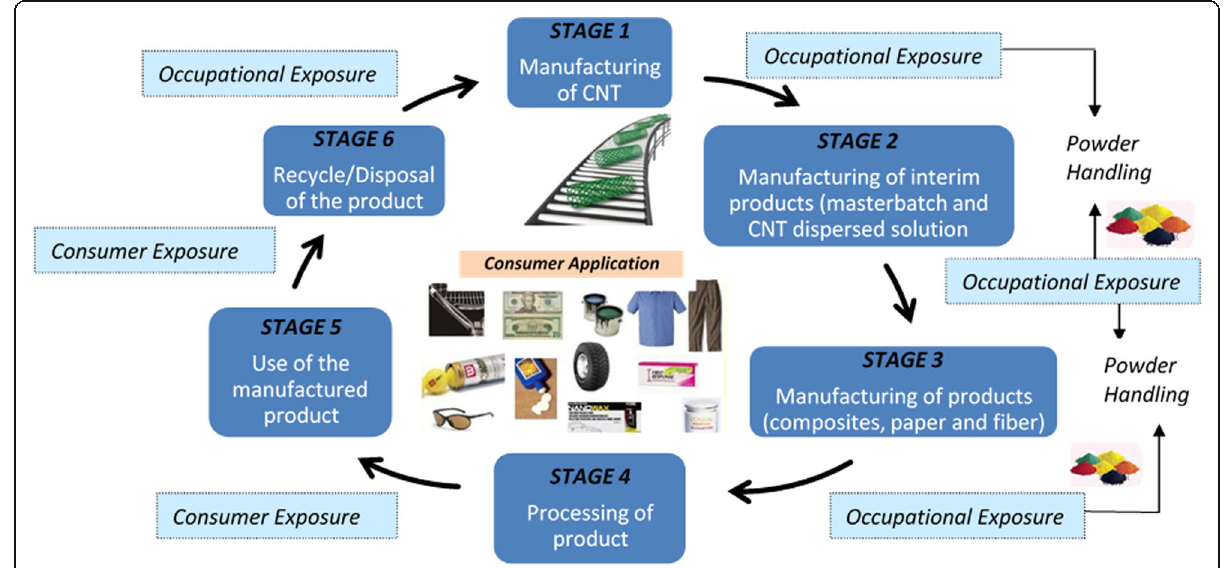
Fig. 2 CNT lifecycle. The life cycle of CNT related to risk assessment studies [18,